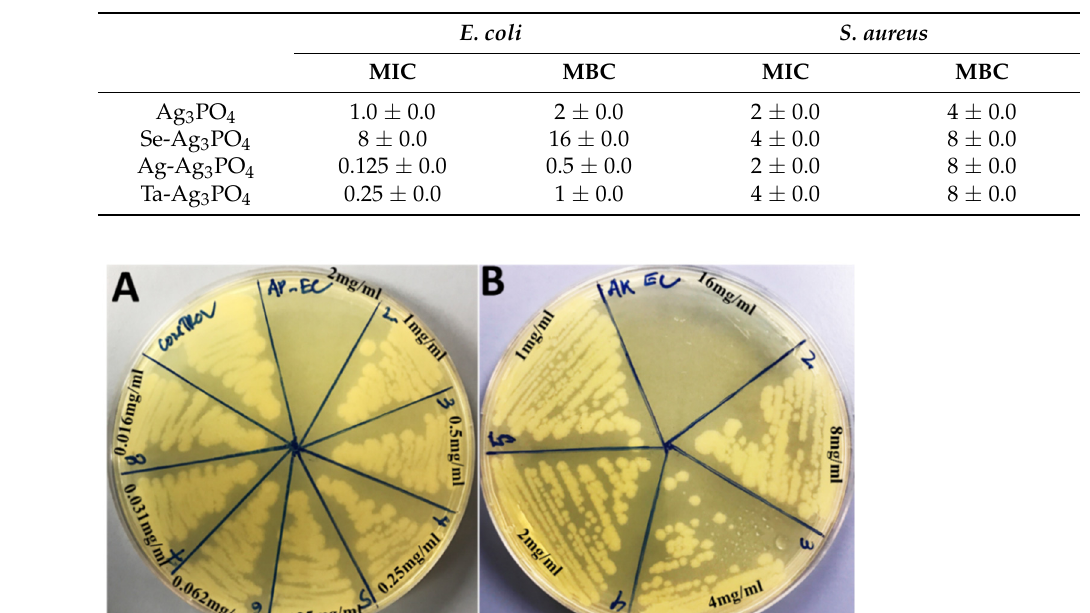
Table 2. MIC and MBC (mg/mL) values of tested compounds against E. coli and S. aureus .